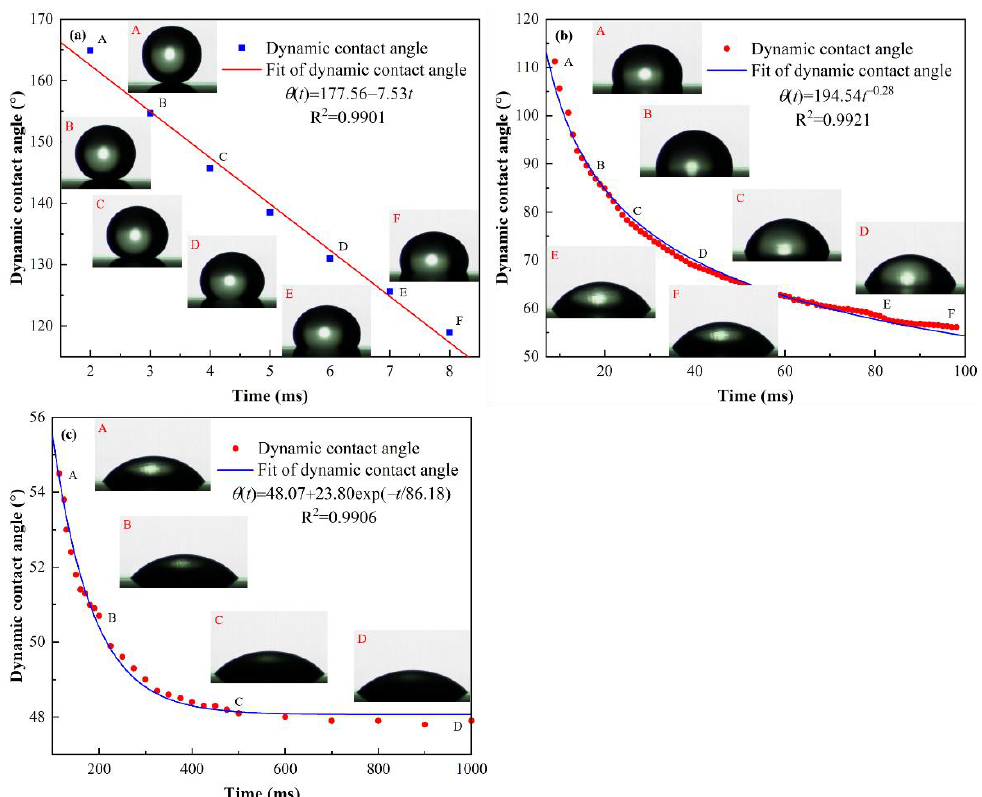
Figure 4. Evolution of dynamic contact angle with time at different time scales during the oil droplet spreading on the Teflon in air. ( a ) t < 10 ms, ( b ) 10 ms ≤ t < 100 ms and ( c ) 100 ms ≤ t ≤ 1000 ms. Note that the scattered dots represent the experimental data, and the solid lines represent the fitting results. The insets correspond to the profiles of an oil droplet at specific moments.